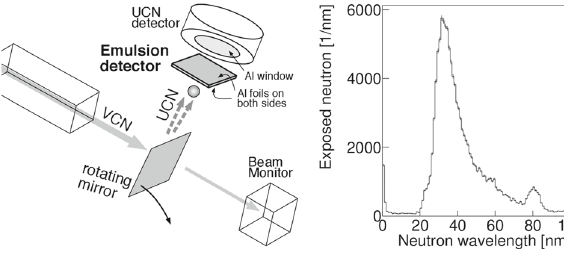
Fig. 5 Left: a schematic view of the experimental set up. Right: the wavelength distribution taken by the UCN